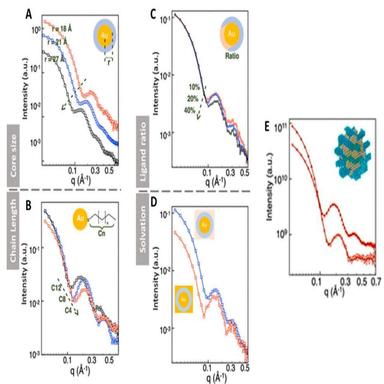
(A) SANS data for MPA-DDT nanoparticles with varying core sizes (1.8 nm, 2.1 nm, and 2.7 nm) and a constant ligand shell in THF-d solvent. (B) SANS data for nanoparticles with the same core size but different ligand chain lengths in toluene‑d solvent. Red curve: DDT and OT ligands deuterated; Blue curve: DDT and BT ligands deuterated; Black curve: OT and BT ligands deuterated. (C) SANS data for MPA-d and OT mixed ligand nanoparticles with different ratios (lMPA:lOT = 1:9, 1:4, and 1:1.5). (D) SANS data for